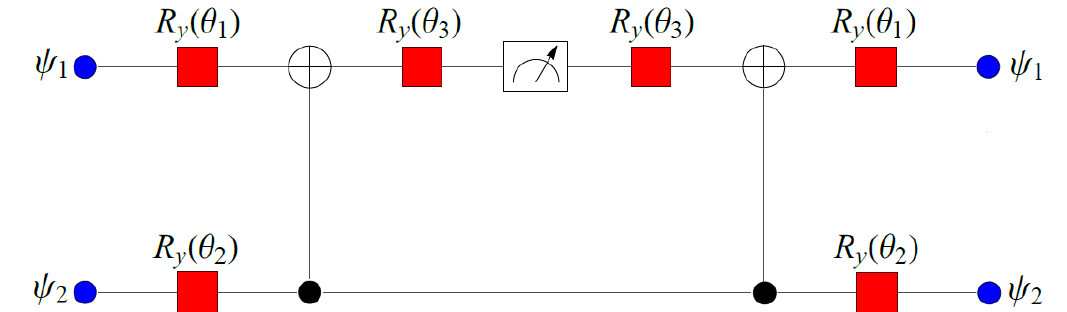
Figure 2. Representation of the score given by the expectation value in Equation (9).